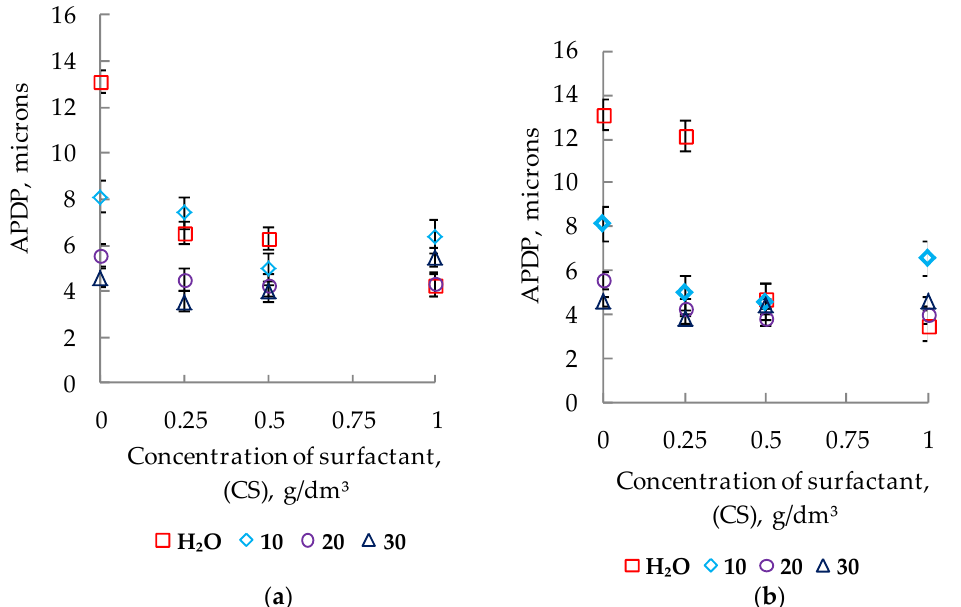
Figure 5. Change in the average particle diameter of the pigment in the presence of NaPA ( a ) and PC ( b ) with the content of the film-forming agent in the system.